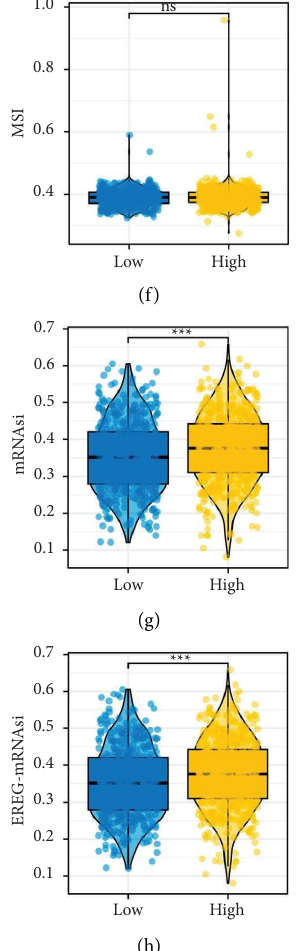
Figure 6: Metabolism and M2 macrophage infltration diferences in patients with diferent risk groups. (a) Biological enrichment of the risk score based on the hallmark gene set; (b) correlation between the risk score and M2 macrophage infltration; (c) M2 macrophage-related molecules were highly expressed in the high-risk patients; (d) metabolism diference between high- and low-risk patients; (e)–(h) TMB, MSI, mRNAsi, and EREG-mRNAsi diference between high- and low-risk